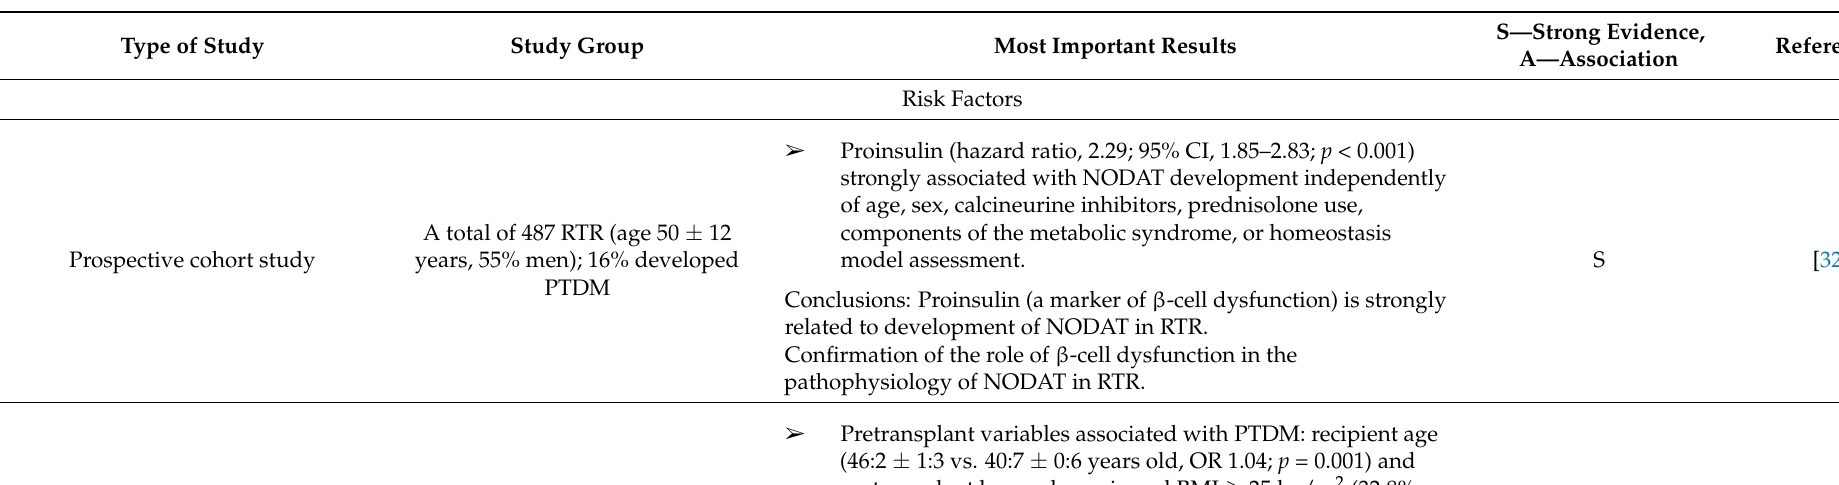
Table 1. The summary of post-transplant diabetes mellitus (PTDM) risk factors and involved pathomechanisms described in this